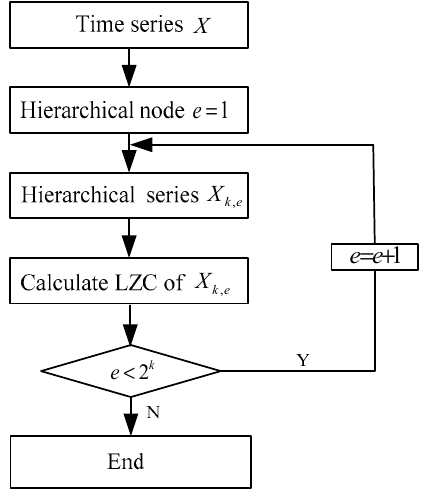
Figure 4. Flowchart of the hierarchical Lempel-Ziv complexity (HLZC)